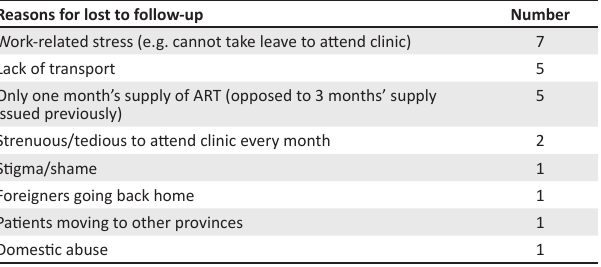
TABLE 4: Reported reasons for lost to follow-up, according to staff